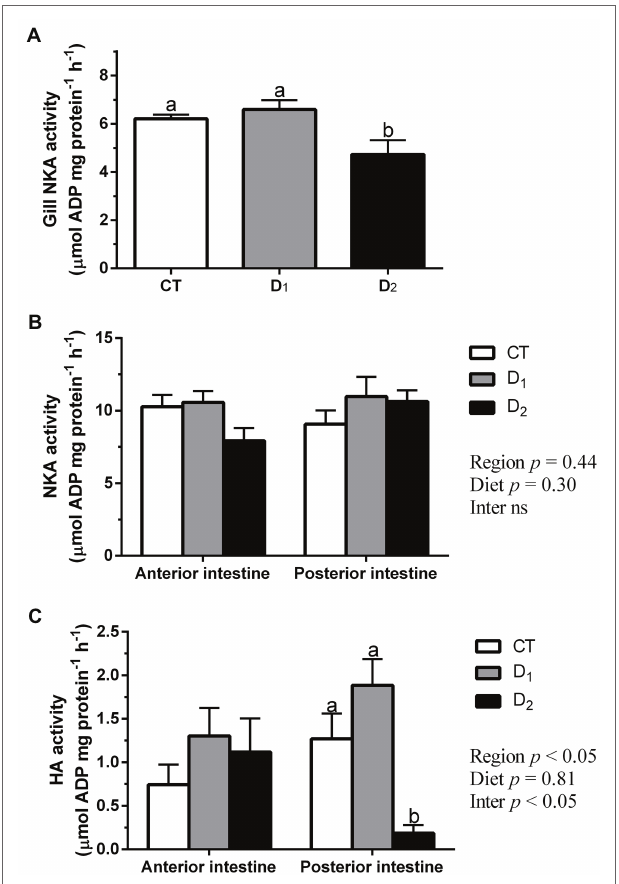
FIGURE 1 | Gill NKA activity (A) , intestinal NKA activity (B) , and intestinal HA activity (C) in S. aurata juveniles fed with different experimental diets (CT, control; D 1 , 1 mg-; and D 2 , 2 mg AFB1 kg − 1 fish feed) for 85 days. Data are presented as mean ± SEM (n = 6–10). Different letters indicate significant differences among the same intestinal regions. Abbreviation “Inter ns”: interaction not significant ( p < 0.05, one or two-way ANOVA followed by Tukey’s post hoc